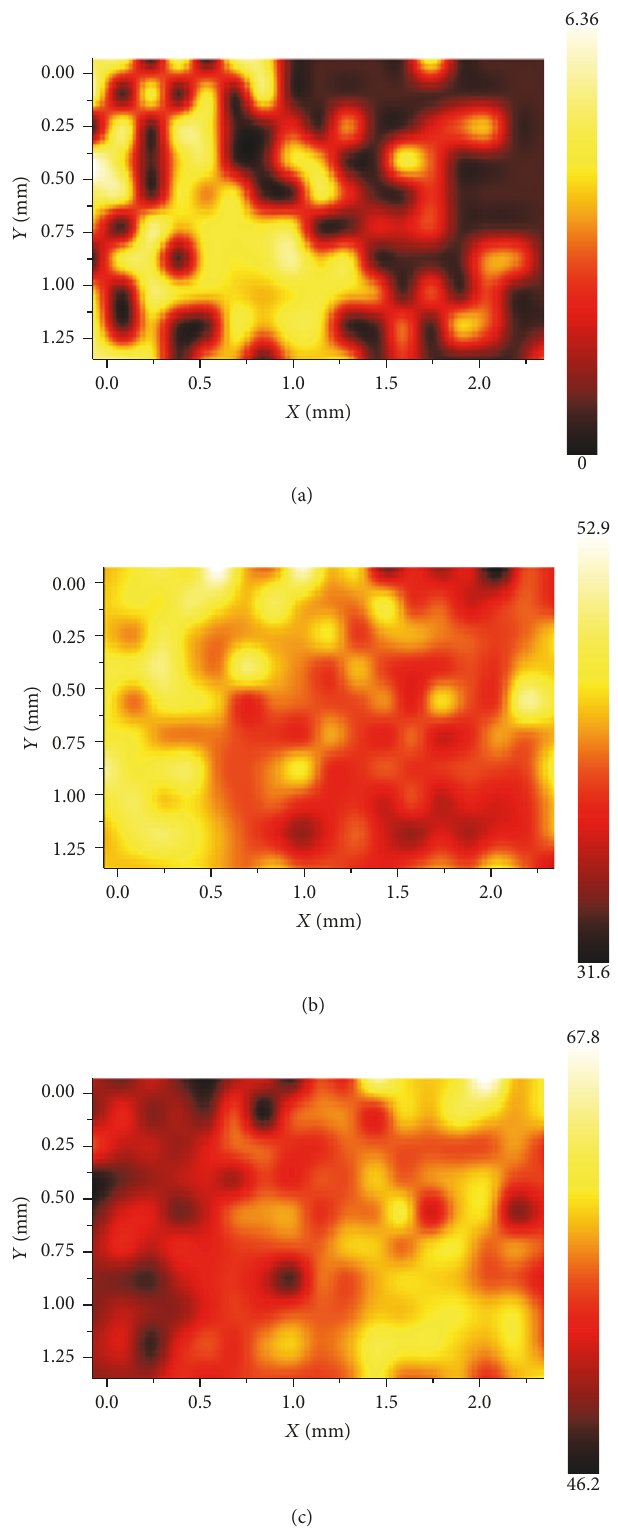
Figure 16: XPS maps for the atomic percentages of (a) Al2p; (b) O1s; and (c) Mg1s for the AZ91D alloy immersed for 6h in 3.5 wt.% NaCl solution at room